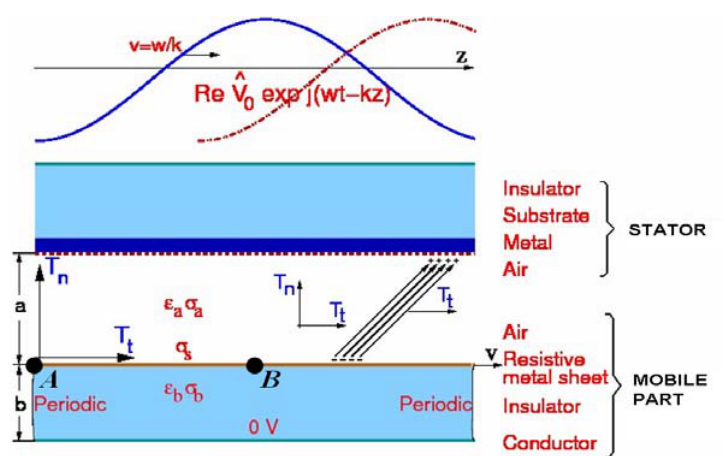
Figure 1. Linear electrical induction